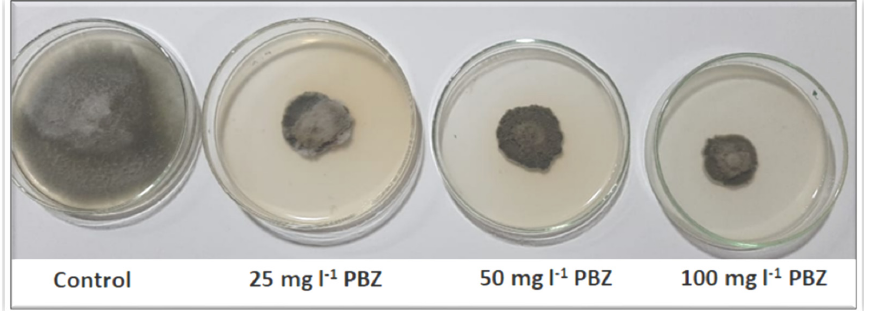
Figure 1. In vitro antifungal activity of paclobutrazol (PBZ) against Alternaria solani. The highest applied dose of PBZ (100 mg L − 1 ) recorded the highest control of this disease, compared to the con- trol.